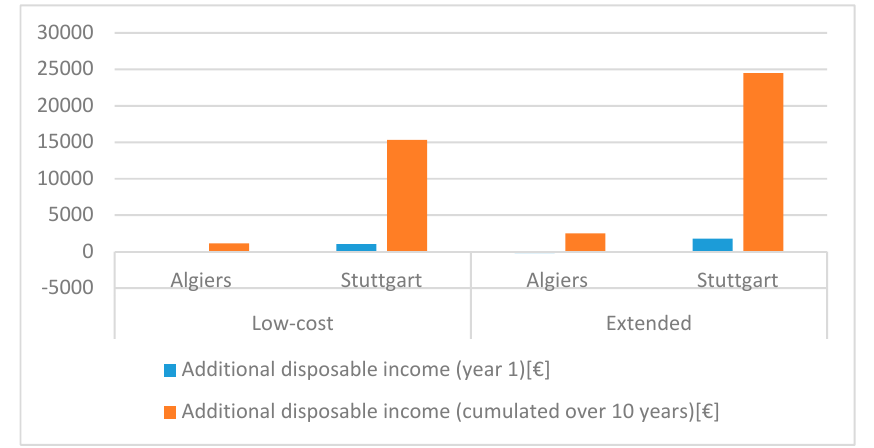
Figure 4. Additional disposable income.